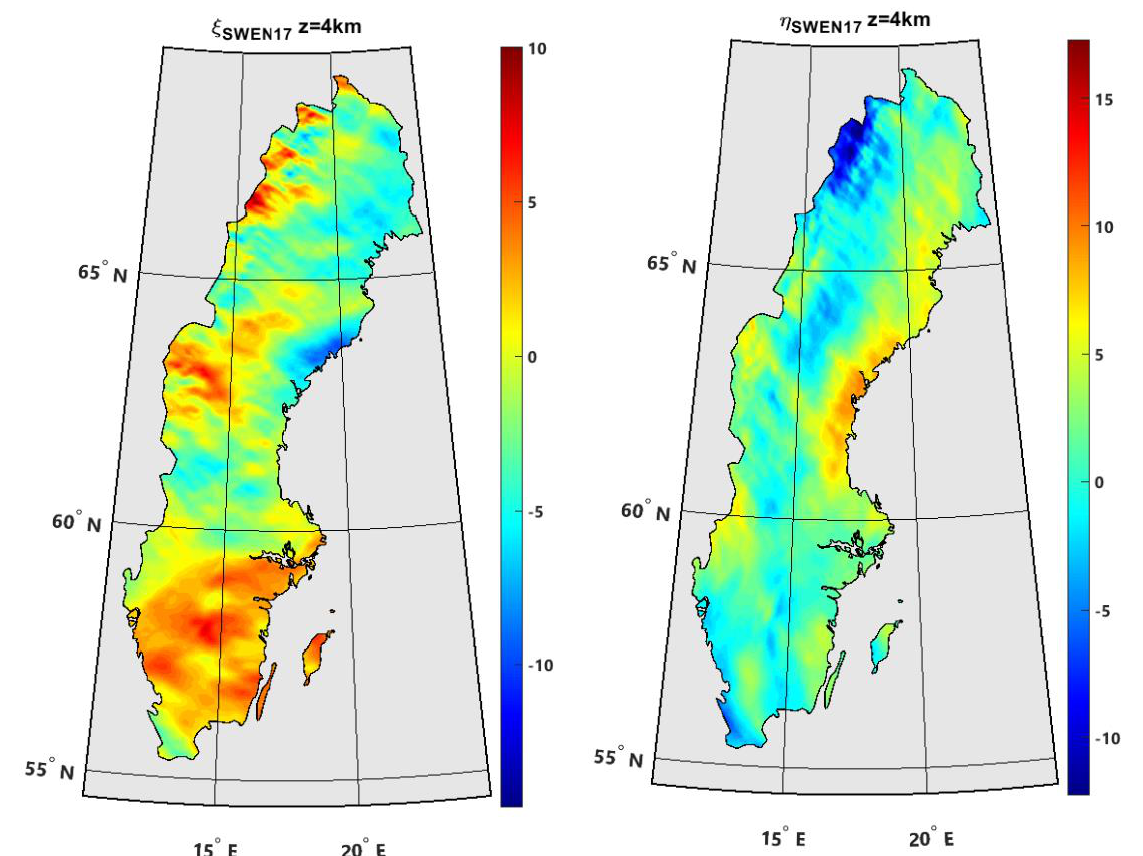
Figure 4 . East-west DOV component (  ) using Figure 3 . North-south DOV component (  ) using SWEN17 for 4 km flight altitudes in Sweden. Unit: arc SWEN17 for 4 km flight altitudes in Sweden. Unit: arc second.